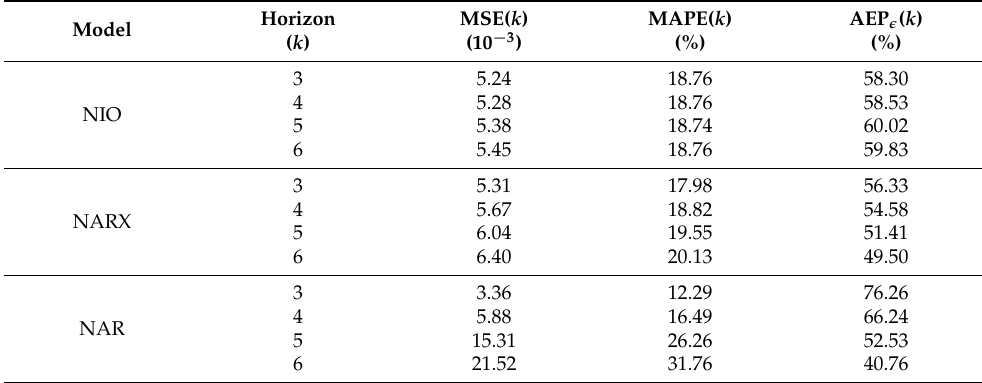
Table 5. Performance of NIO, NARX, and NAR models after implementing the pruning algorithm.